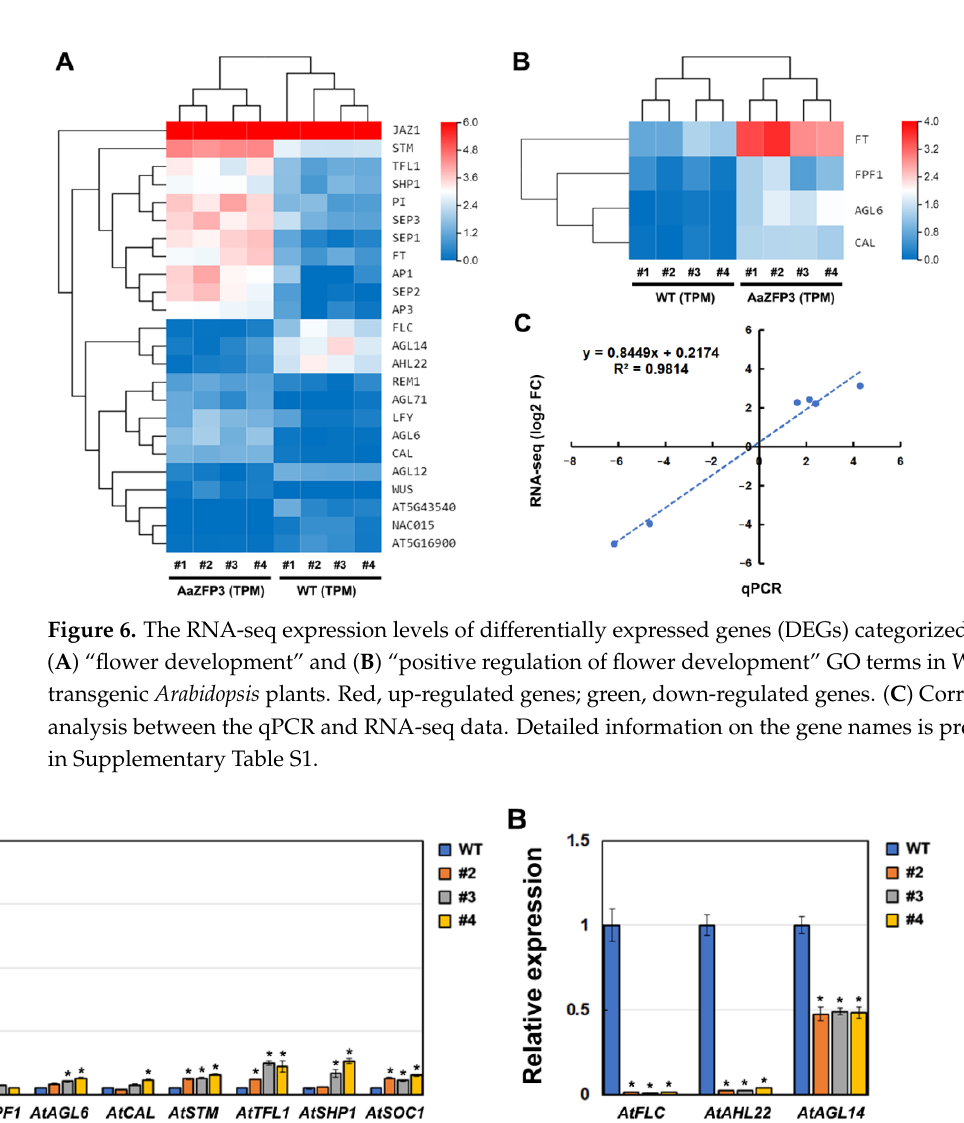
Figure 7. qPCR validation of key differentially expressed genes (DEGs) involved in flowering time control and flower development. ( A , B ) qPCR results showing the relative expression levels of ( A ) up-regulated and ( B ) down-regulated DEGs in transgenic Arabidopsis lines compared to WT plants. The AtActin gene was used as an internal control and its transcript level in WT plants was set to 1.0. Error bars represent the standard error ( n = 3). Asterisks indicate significant differences between the transgenic lines and WT plants (Student’s t -test; p < 0.01). Detailed information on the gene names is provided in Supplementary Table S1.